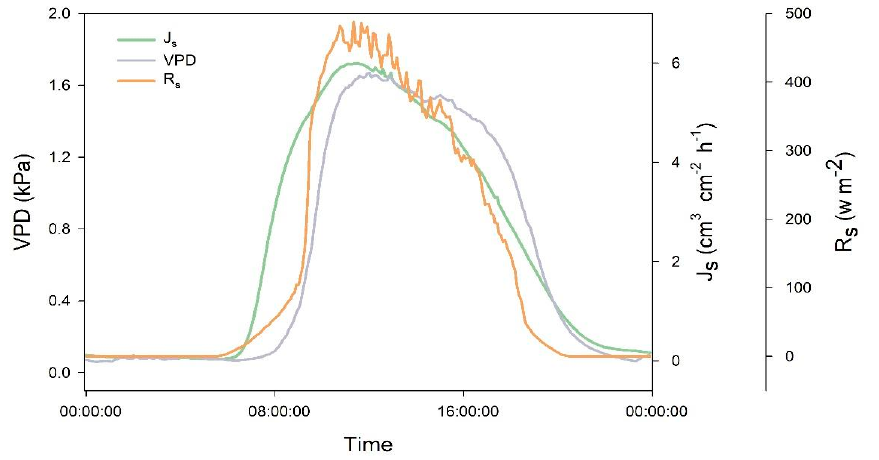
Figure 2. Diurnal variations in sap flux density (J s ), vapor pressure deficit (VPD) and solar radiation (R s ). Time zone: GMT+8.